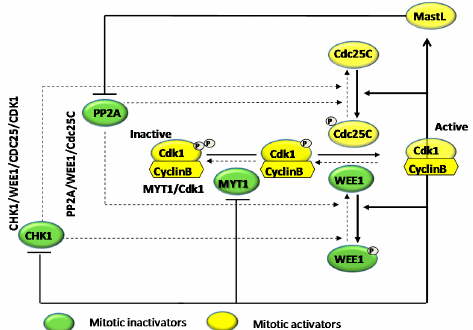
Figure 1. Transition from G2-checkpoint arrest to mitosis. For simplicity, a solid line represents how CDK1–cyclin B triggers entry into mitosis and a dashed line represents Cdk1-inactivating pathways (CHK1/WEE1/Cdc25C/Cdk1, MYT1/Cdk1, and PP2A/WEE1/Cdc25C). Abbreviations: Cdk1, cyclin-dependent kinase 1; CHK1, checkpoint kinase 1; MYT1, membrane associated tyrosine/threonine 1 kinases; PP2A, protein phosphatase 2.